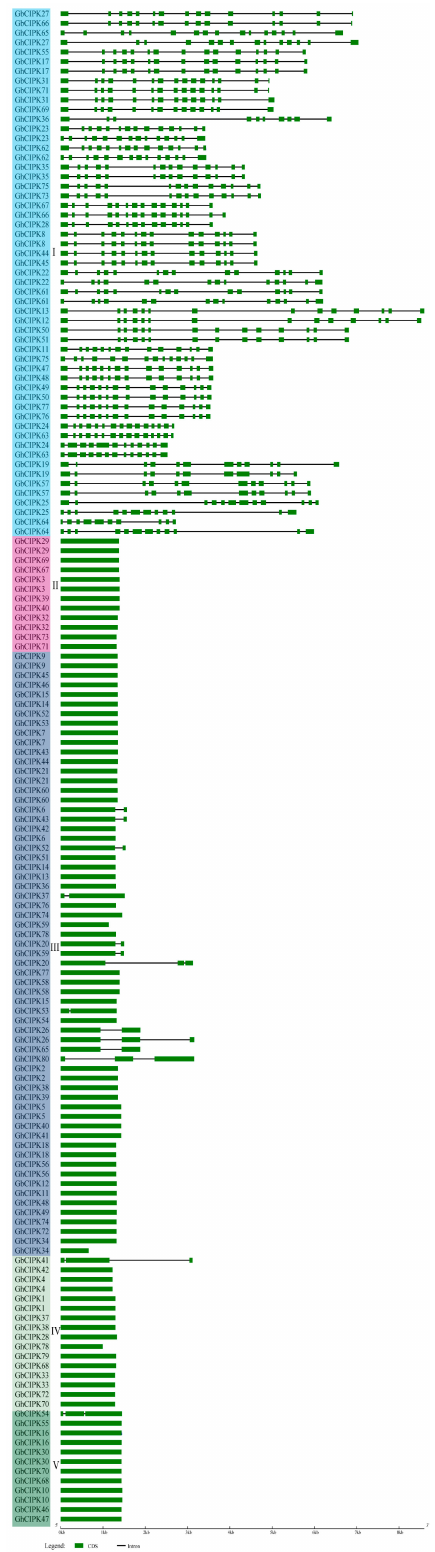
Figure 2. The gene structure of CIPK genes in G. hirsutum and G. barbadense . Introns are presented by black lines and exons by green